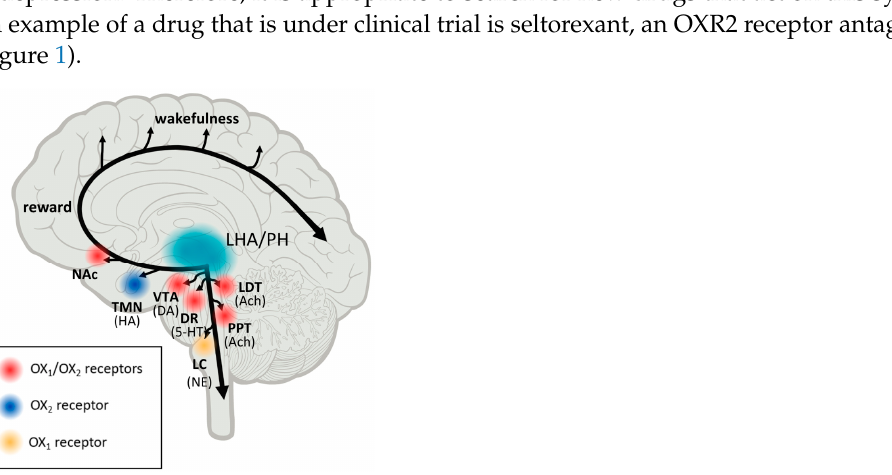
Figure 1. The OxR and orexin pathways linked to states of alertness, wakefulness, and pleasure. LHA, the lateral hypothalamic area; PH, posterior hypothalamus; NAc, nucleus accumbent; TMN, tuberomammillary nuclei; LDT, PPT, laterodorsal and pedunculopontine tegmental nuclei; LC, the locus ceruleus; DR, dorsal raphe nuclei; VTA, the ventral tegmental area; HA, histaminergic; DA, dopaminergic; ACh, cholinergic; NE, noradrenergic; 5-HT, serotonergic. Turquoise, orexinergic neuron projections; yellow, preferential OX1 receptor expression; blue, preferential OX2 receptor expression; red, both OX1 and OX2 receptor expression.